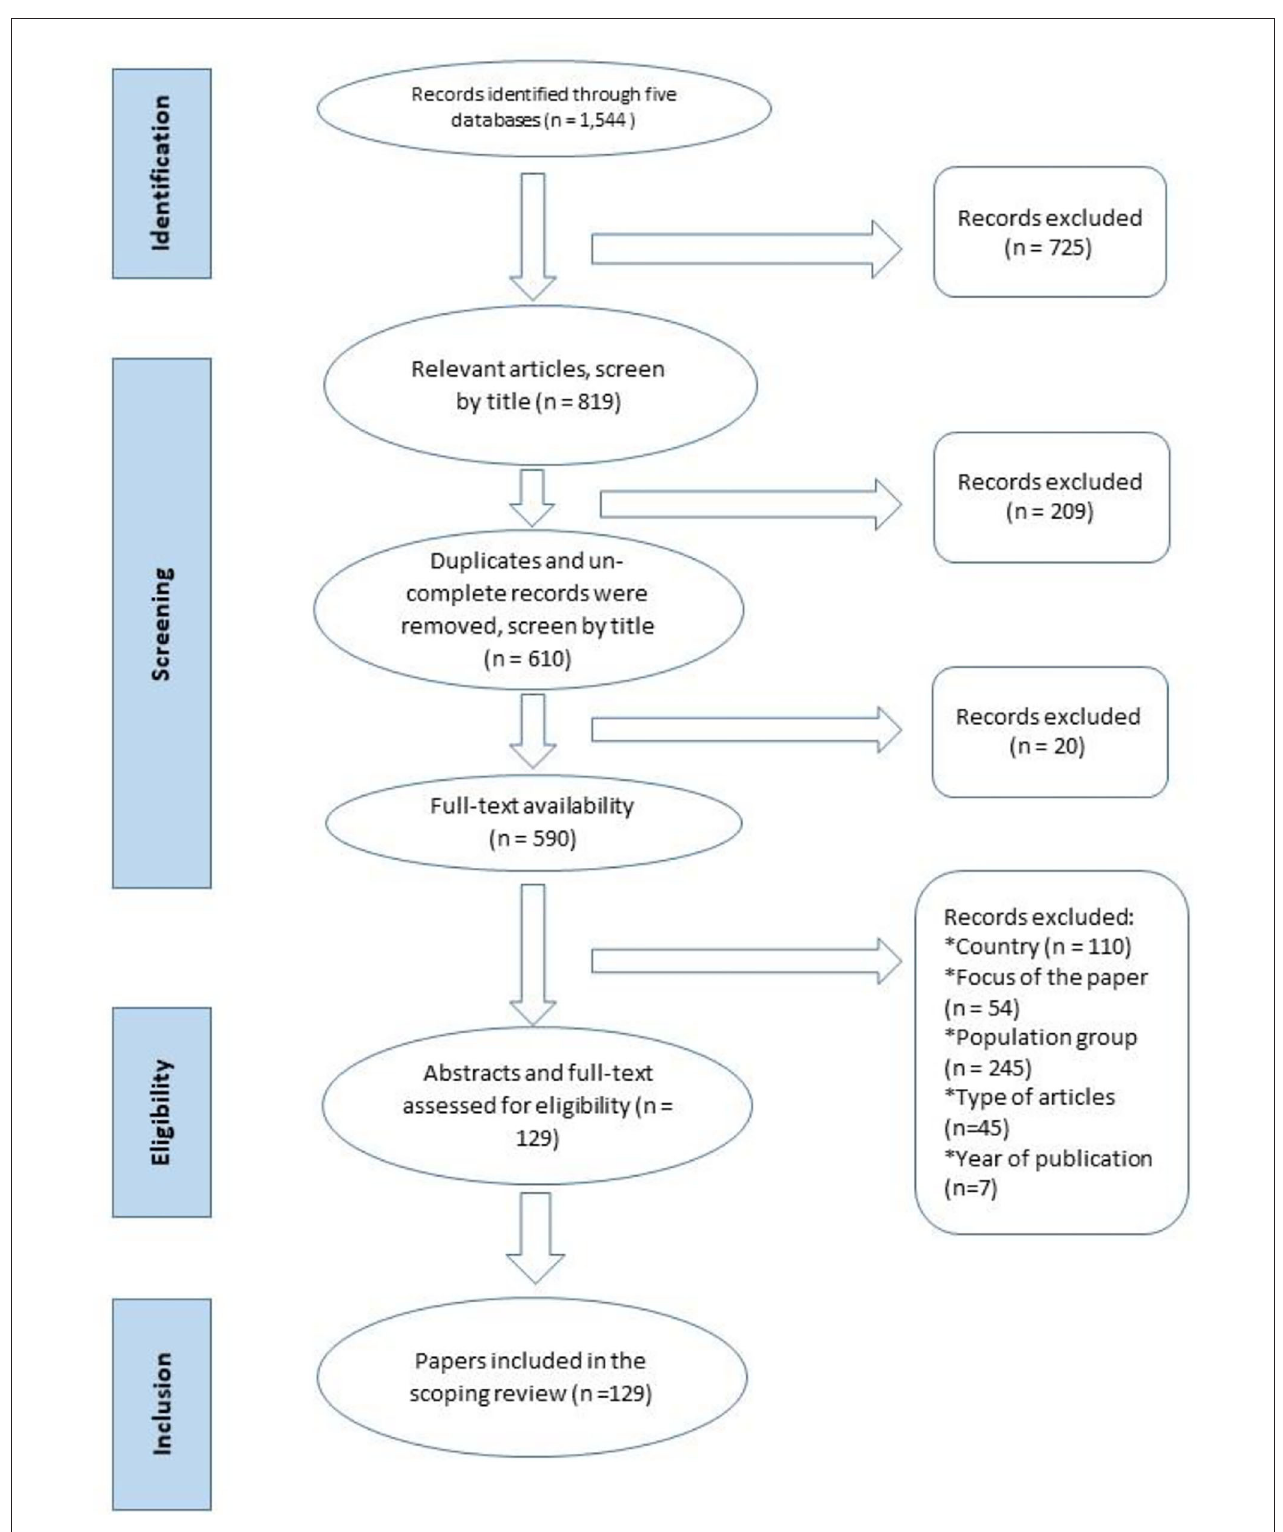
FIGURE 1 | PRISMA flow diagram of scoping review stages based on Arksey and O’Malley (16).